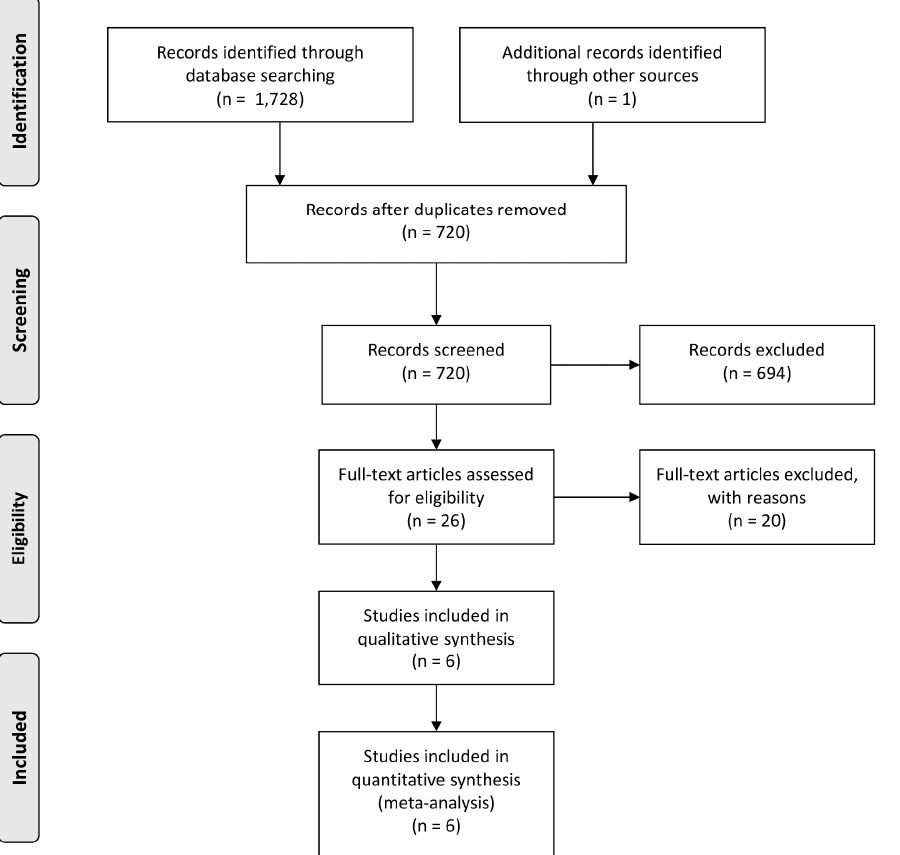
Figure 1. A flow chart showing literature search approach used in this meta-analysis.